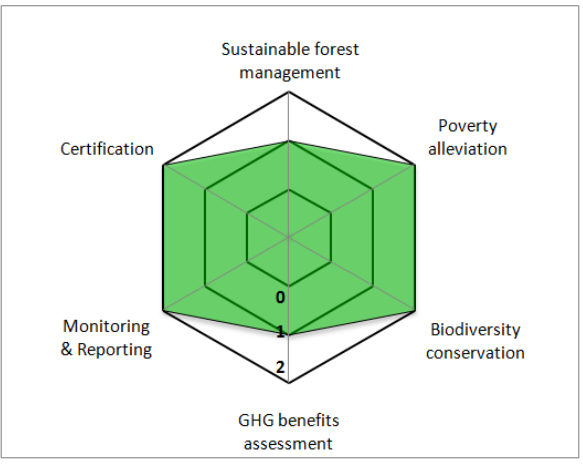
Figure 4. Summary of Climate, Community and Biodiversity